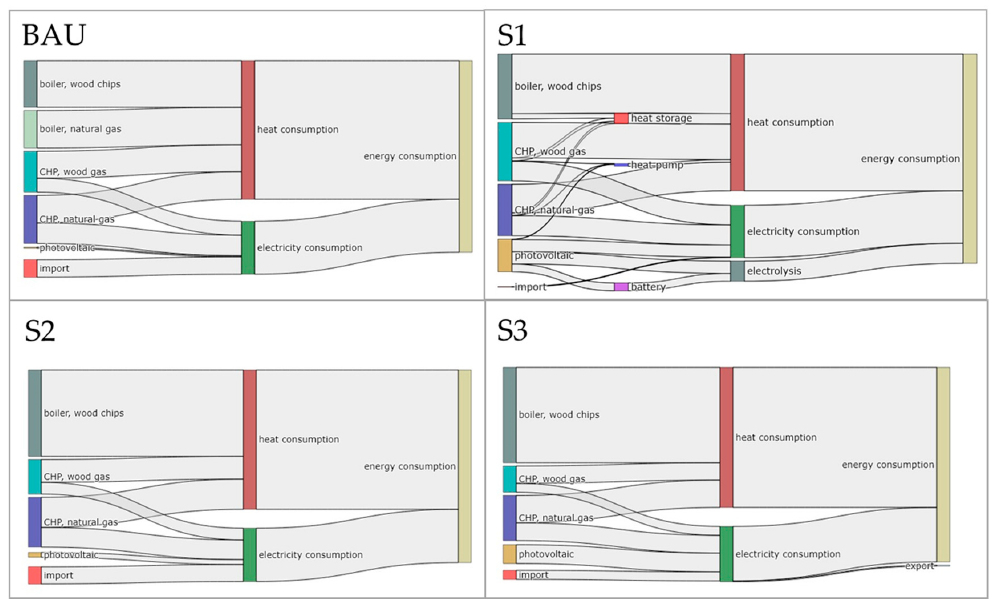
Figure 3. Sankey diagrams of the system configuration.